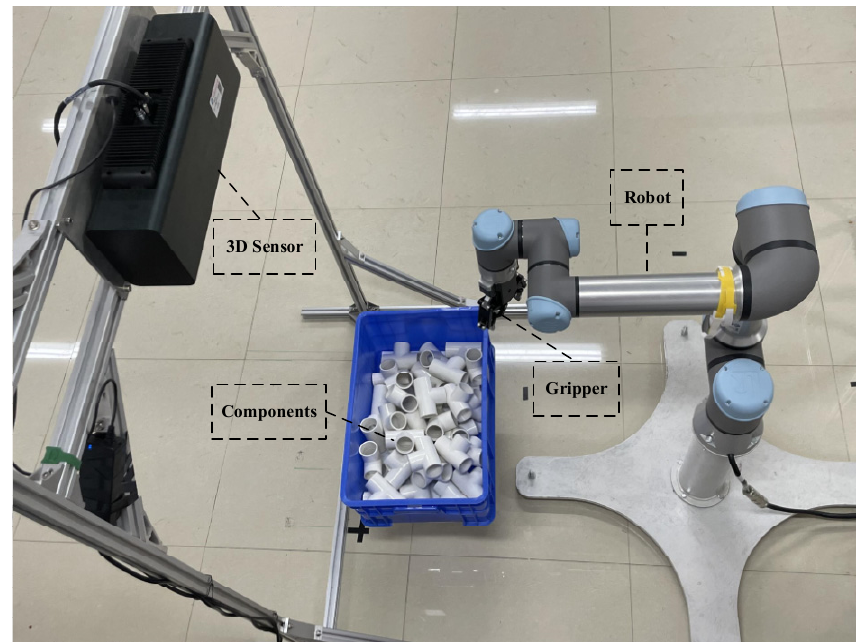
Figure 15. Bin-picking system diagram. The system is composed of robot, gripper, components, and 3D sensor.